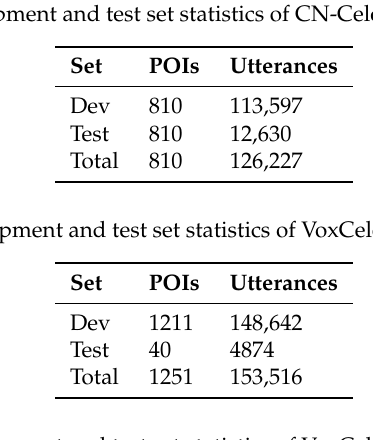
Table 4. Development and test set statistics of VoxCeleb2 for